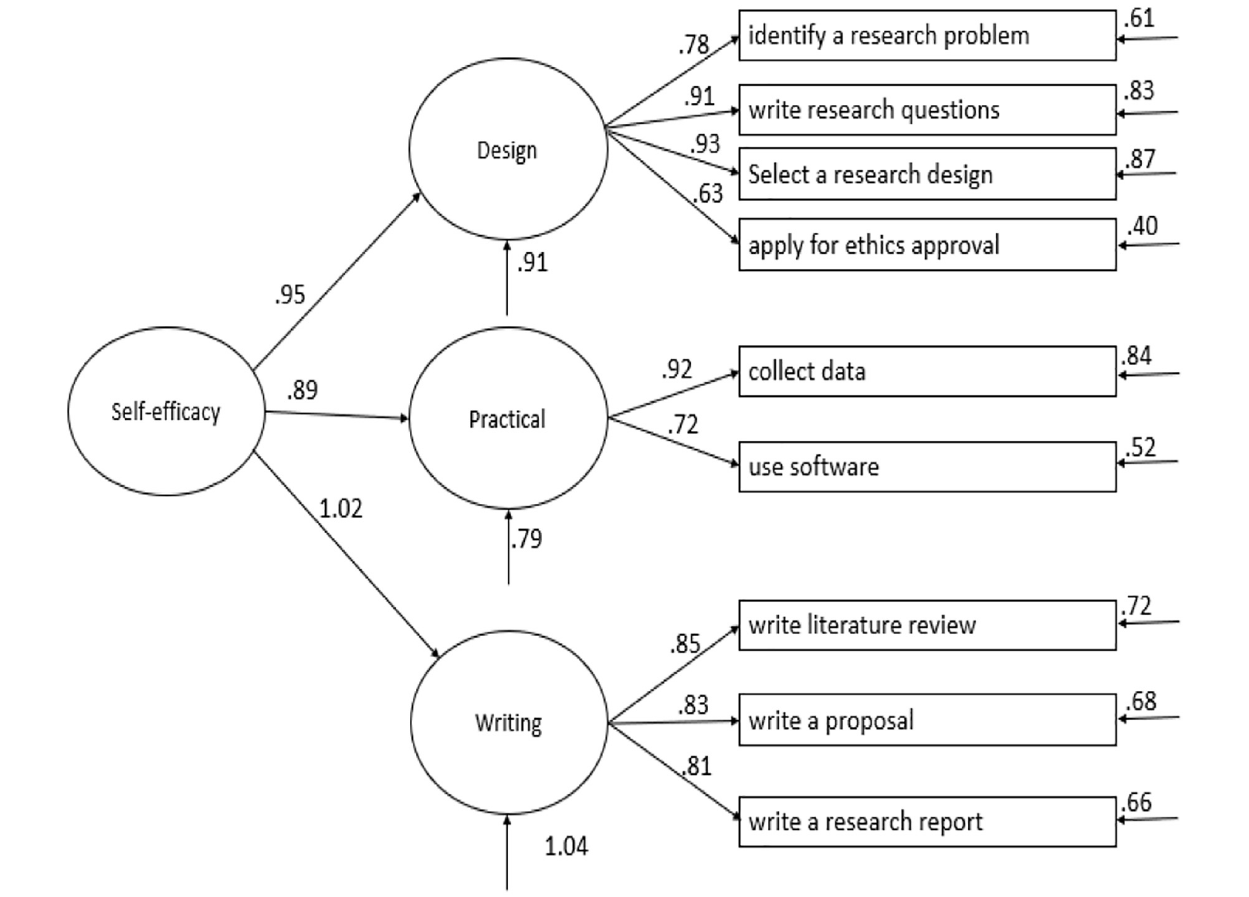
Frontiers in Psychology |